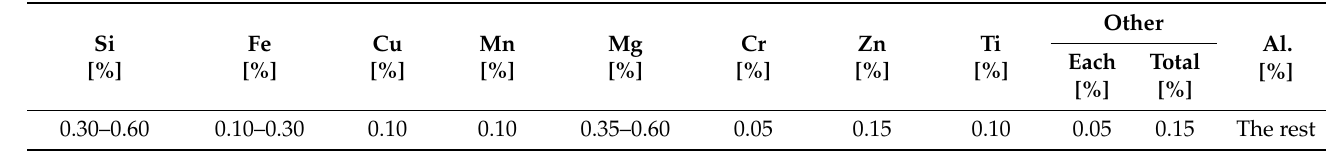
Table 1. Chemical composition of the aluminum alloy 6060 T4 in accordance with the PN-EN 573-